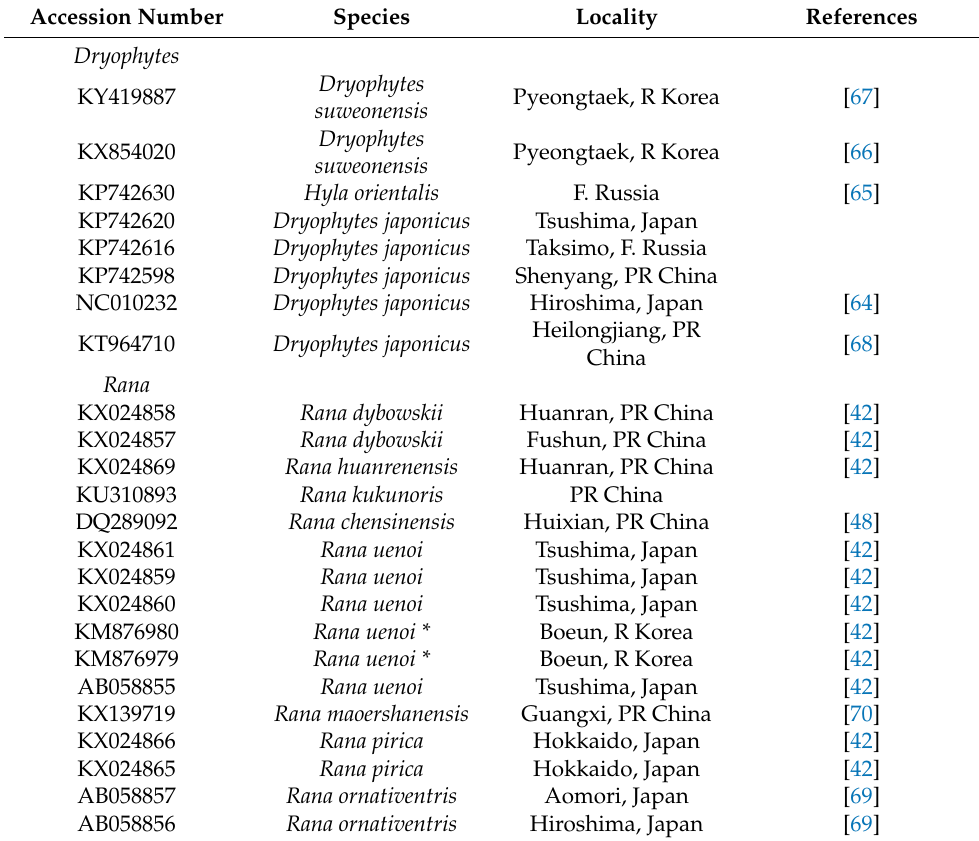
Table 2. List of samples with GenBank accession numbers used in this analysis. The species identification for individual Rana dybowskii samples from R Korea was arbitrarily reassigned to R. uenoi based on [40]. These individuals are indicated by *. References are indicated when available or left